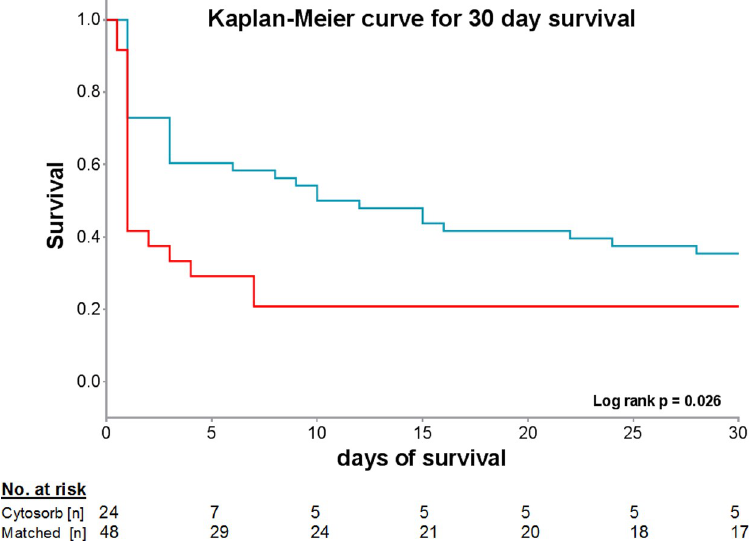
Fig 1. Kaplan-Meier curve for 30-day mortality in the CytoSorb 1 (red line) and matched control group (blue